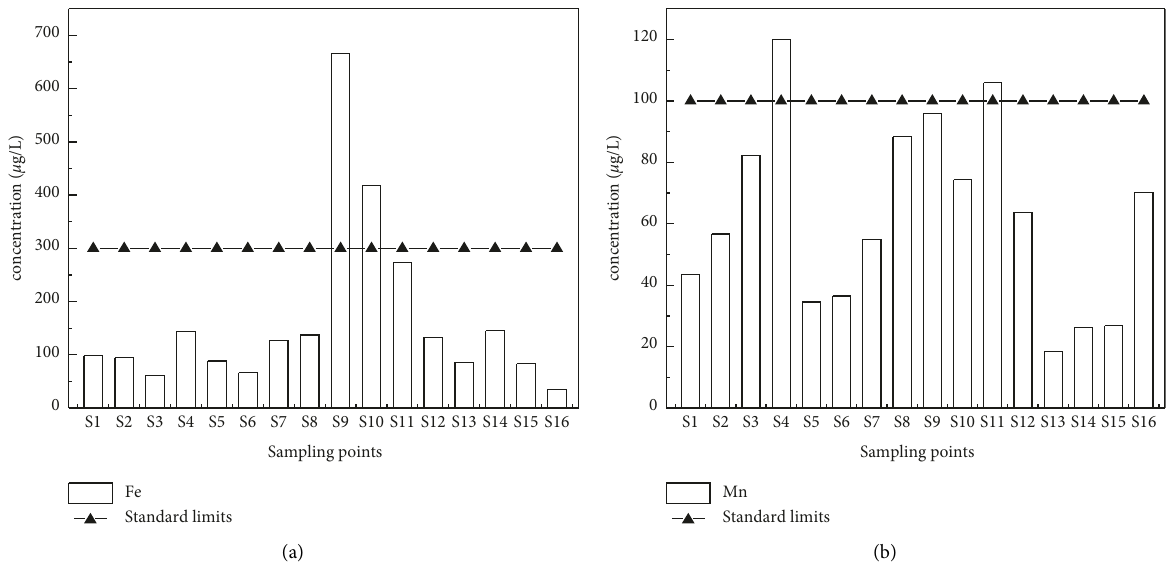
Figure 4: The content of Fe (a) and Mn (b) at each sampling point in the Huainan coal mining subsidence water bodies. (The standard limits of Fe and Mn in the figure refer to the standard limits of supplementary items of centralized surface water sources for drinking